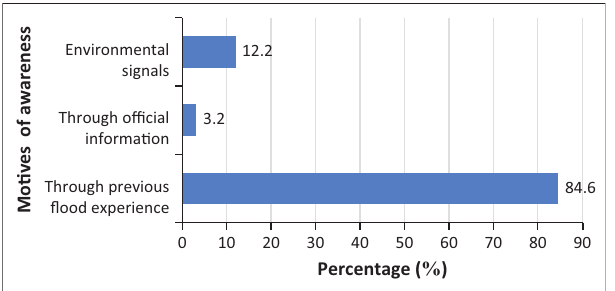
FIGURE 7: Percentage of respondents’ practice of preparatory measures for flood